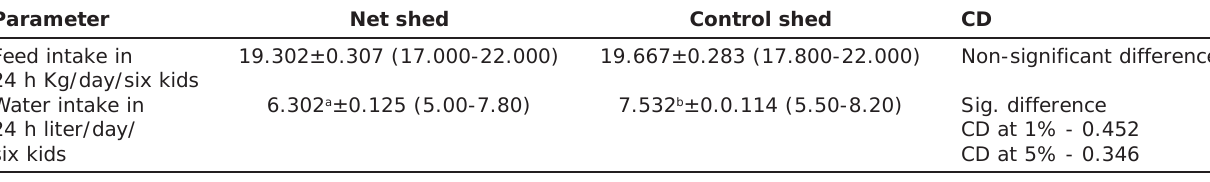
Table-9: Feed and water intake by kids in the net and control